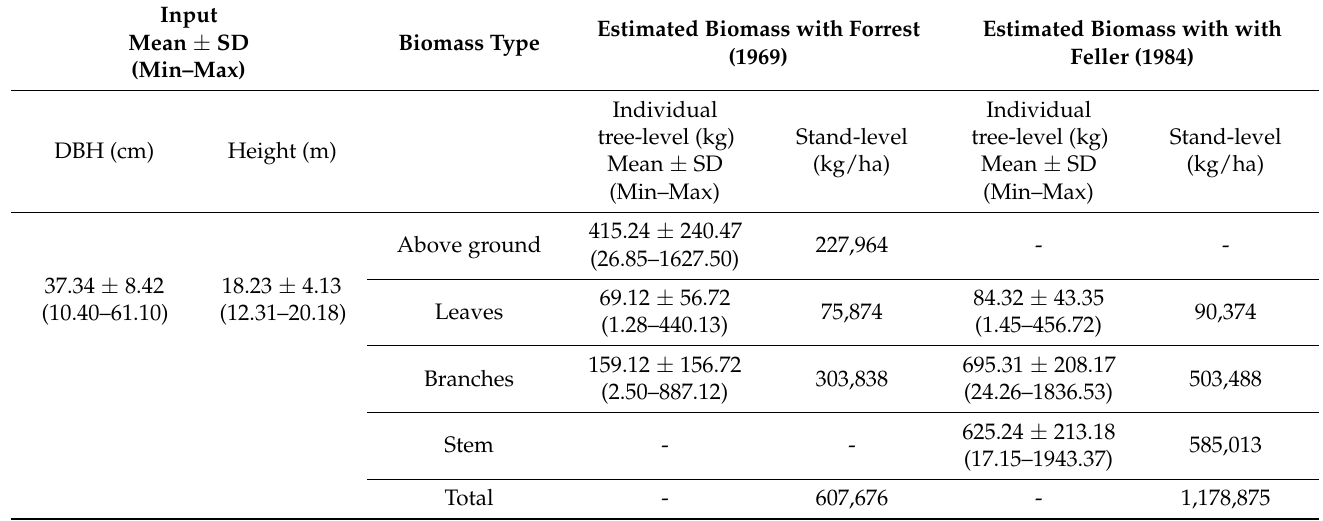
Table 3. Radiata pine allometric equation and estimated total harvesting residue in the case study (equations were developed by Forrest [29] and Feller’s